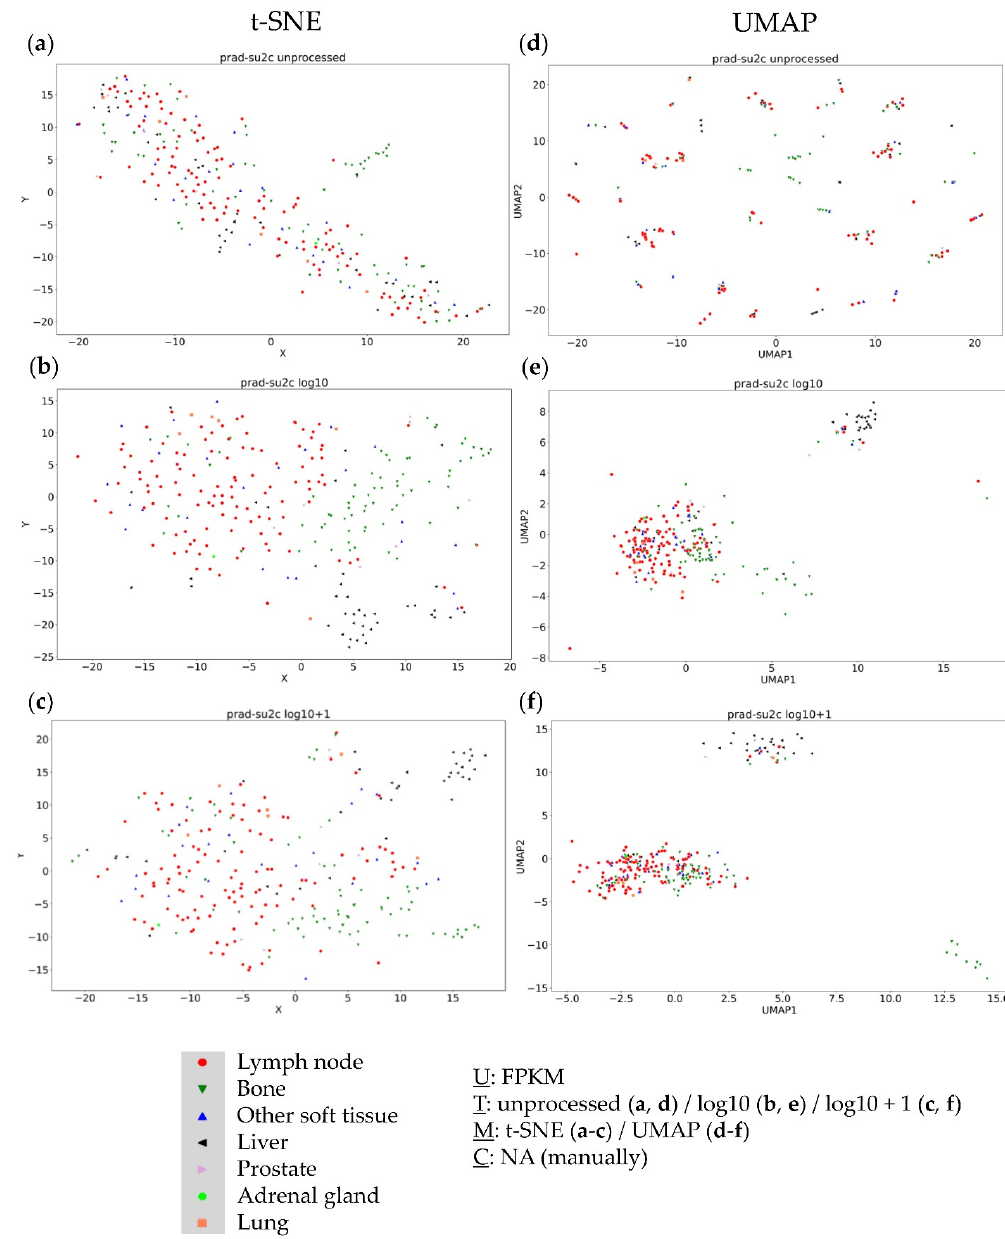
Figure 1. Visual clustering of the Dream Team dataset consisting of metastatic prostate cancer (with respective resection sites) by applying different data dimension reduction methods. t-SNE plot approach for ( a ) unprocessed, ( b ) log10 transformed, and ( c ) log10 + 1 transformed FPKM values and UMAP approach using ( d ) unprocessed, ( e ) log10 transformed, and ( f ) log10 + 1 transformed FPKM values. FPKM: Fragments Per Kilobase Million; U: unit, T: transformation, M: data dimension reduction method, C: clustering method, NA: not applicable.